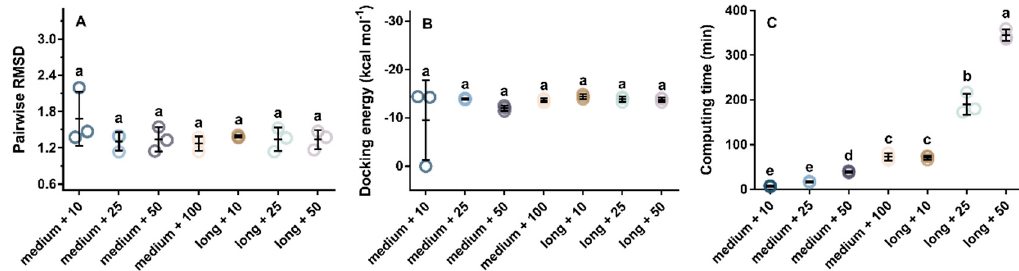
Figure 5. Effect of the maximum number of energy evaluations (medium and long) and the number of genetic algorithms (10, 25, 50, and 100) on the docking result of lisinopril with ACE: pairwise RMSD ( A ), docking energy ( B ), and computing time ( C ). RMSD was root mean square deviation.